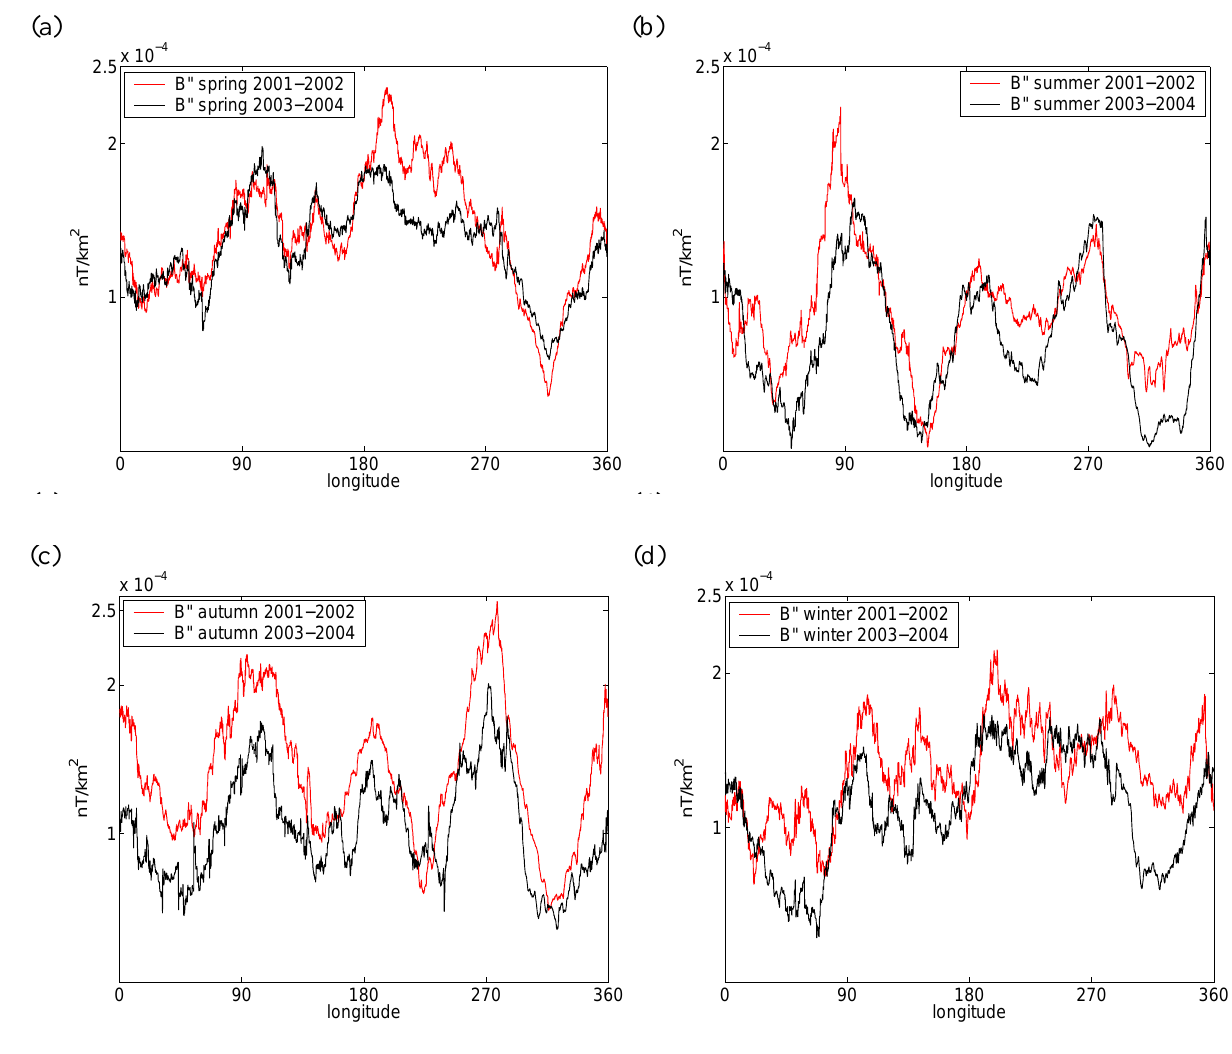
Fig. 12. Seasonal variation of the longitude profile of the equatorial electrojet field, lon- gitudinal component, in nT/km 2 : spring (a), summer (b), autumn (c) and winter (d). The profiles are computed over 2001-2002 (red curves) and 2003-2004 (black curves).